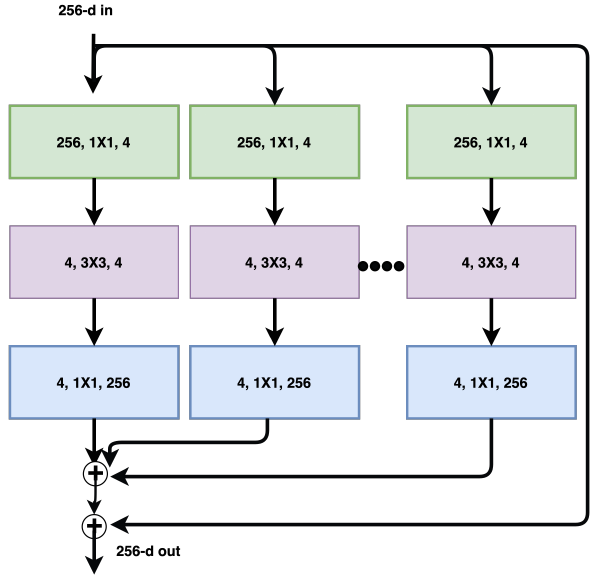
Figure 11. ResNeXt backbone module showing different paths for feature